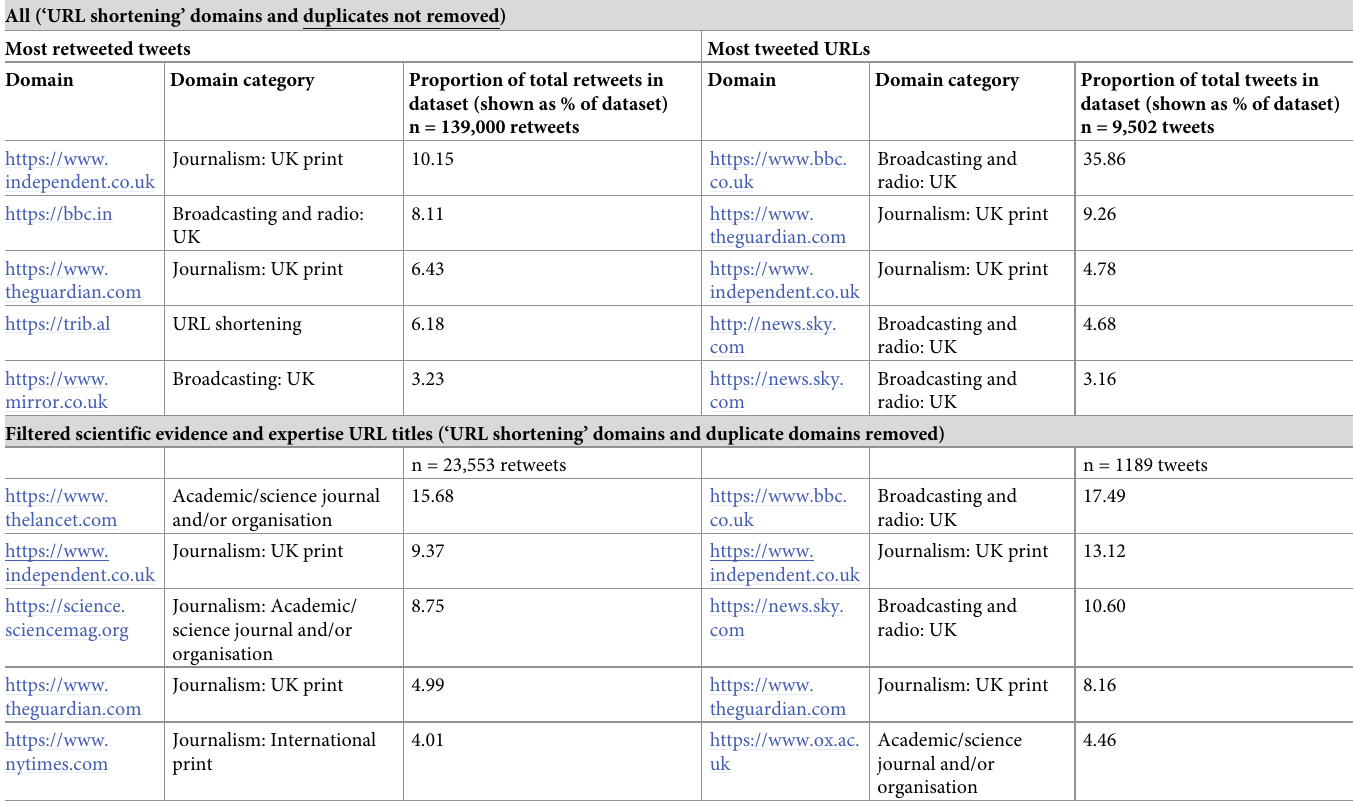
Table 8. Top five domains in each dataset based on total number of retweets/tweets within dataset. All (‘URL shortening’ domains and duplicates not removed) Most retweeted tweets Most tweeted